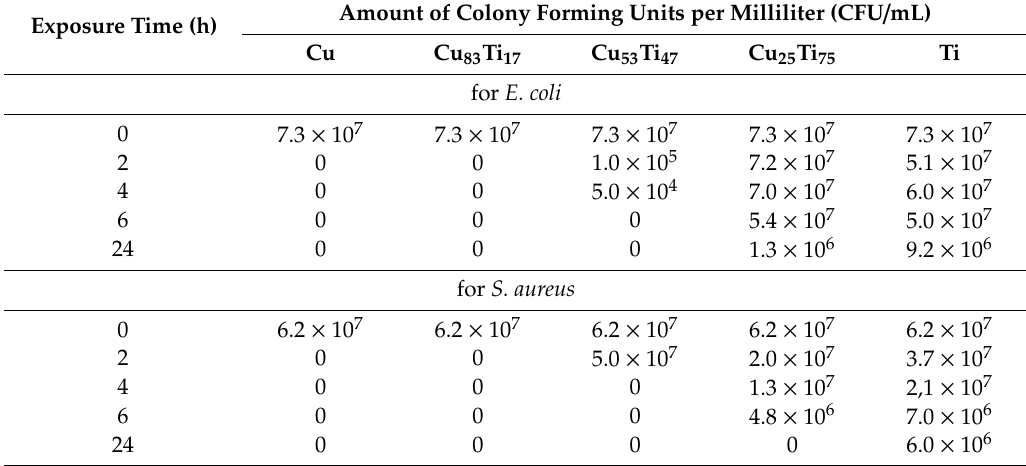
Table 3. Antimicrobial activity of thin films based on Cu and Ti for E. coli and S. aureus . Exposure Time